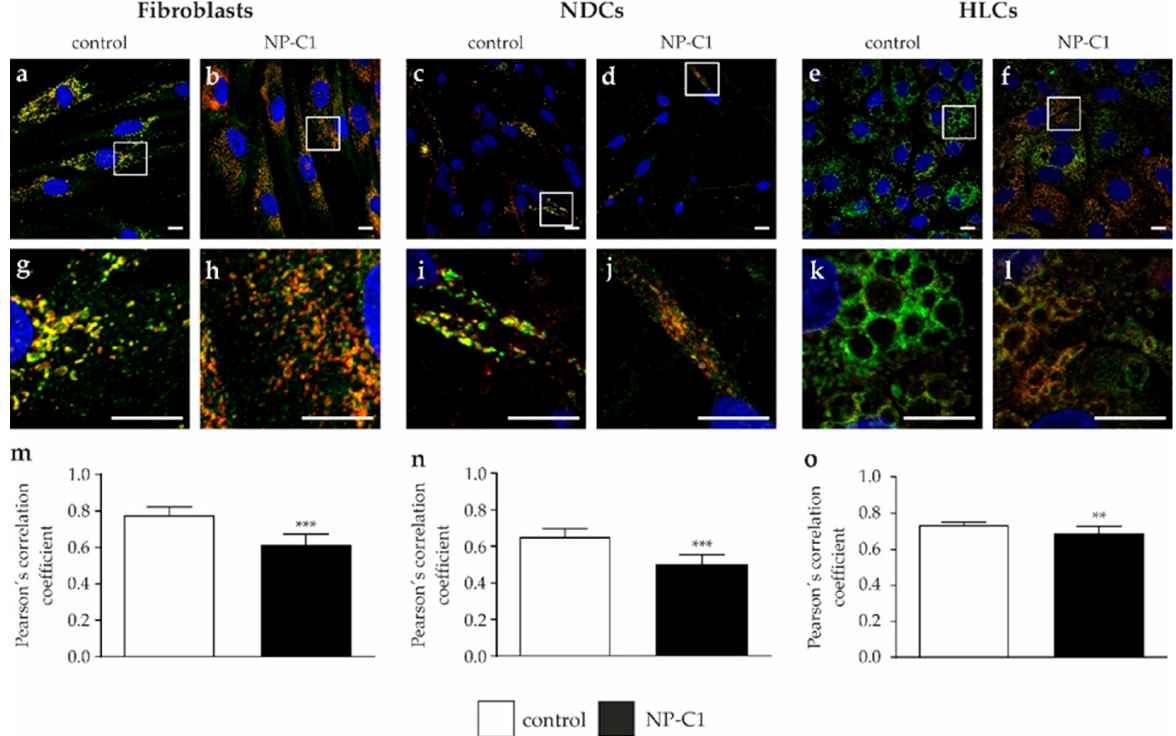
Figure 6. Analysis of NPC1 localization. Immunofluorescence pictures were used to determine the colocalization of NPC1 protein (green) and LAMP2 (red) as a lysosomal marker protein, in fibroblasts ( a , b ), NDCs ( c , d ), and HLCs ( e , f ). Magnified images of the squared region of each image are shown below ( g – l ). DAPI was used to counterstain nuclei (blue, a – l ). ( m – o ) Calculation of Pearson´s correlation coefficient revealed strong colocalization in all cell types, although NP-C1 mutated cells showed a significantly lower colocalization. Scale bar = 10 µm. ** = p < 0.01, *** = p < 0.001.